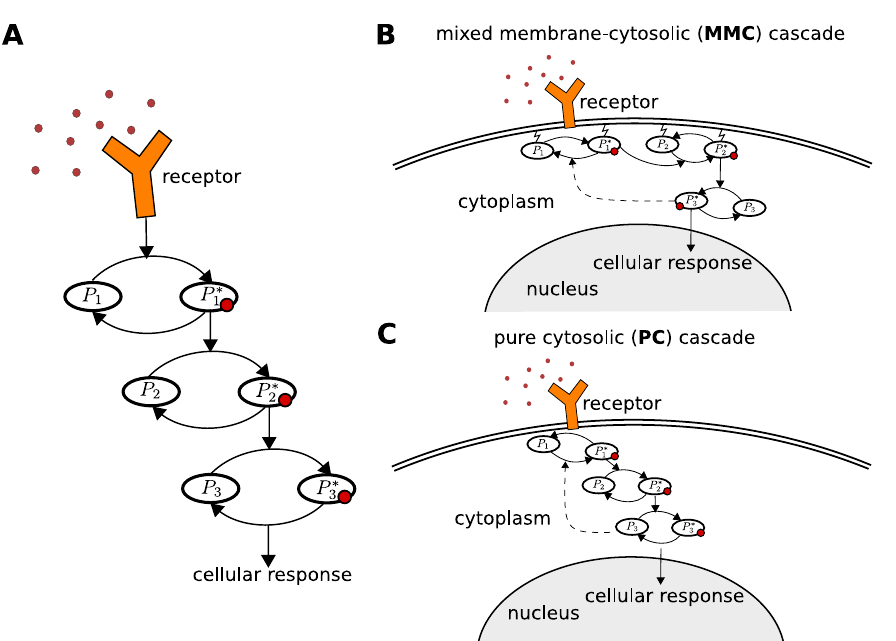
Fig 1. Spatial organization of signaling cascades. ( A ) Sketch of the classical temporal signal transduction model. Extension of this model into three-dimensional space naturally results in a variety of different spatial motifs. ( B ) The signal is first processed by signaling components tethered to the membrane, and then transduced at membrane- cytosolic interface into the cytosol. ( C ) The signaling components are directly activated at the membrane-cytosolic interface and diffuse through the cytosol. Note that diffusion coefficients for lateral diffusion along the membrane are much lower than in the